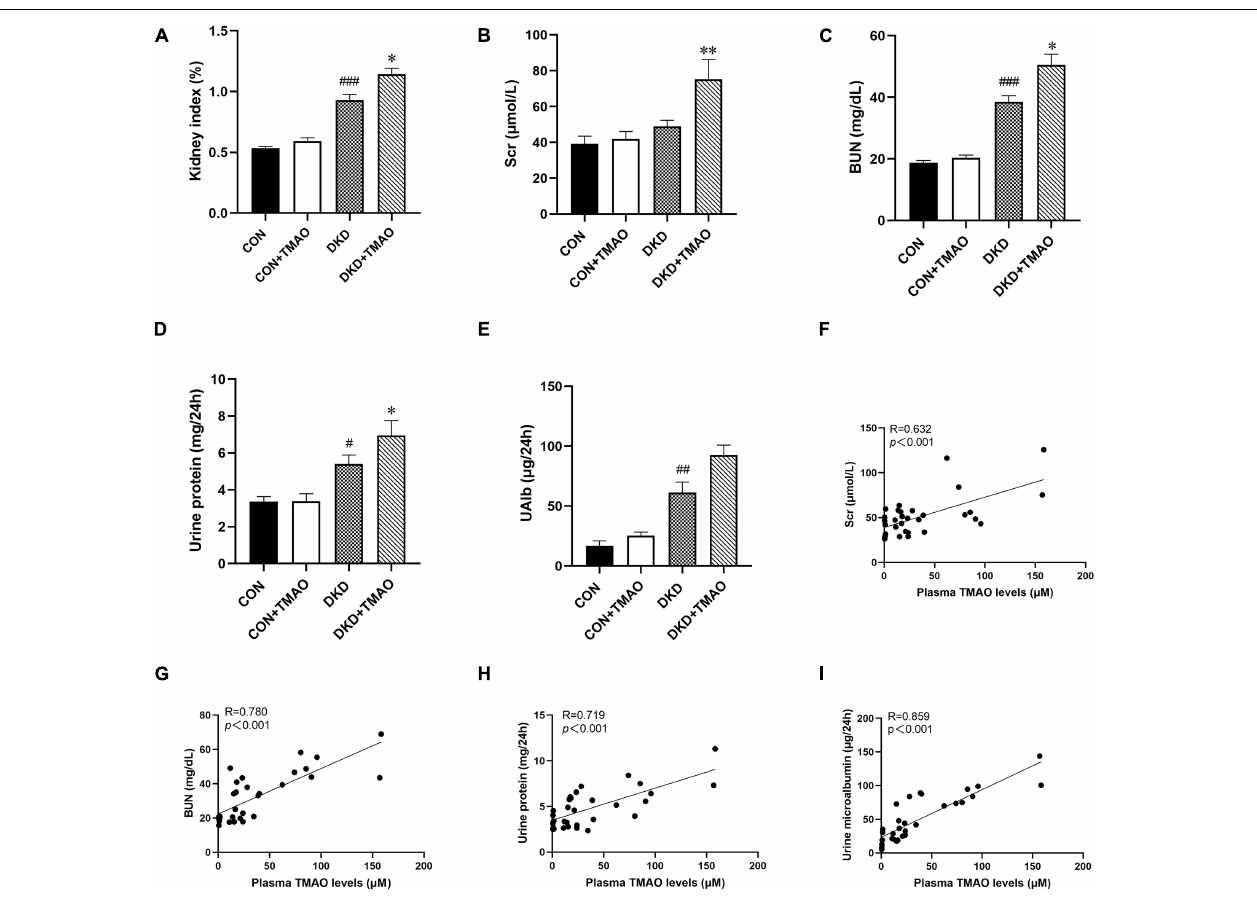
FIGURE 3 | Parameters of renal function in rats. (A) Kidney index (kidney weight/body weight), (B) Scr, (C) BUN, (D) Urine protein, (E) Urine microalbumin. Plasma TMAO levels were significantly correlated with renal function parameters Scr (F) , BUN (G) , Urine protein (H) , and Urine microalbumin (I) . Data are presented as mean ± SEM ( n = 8 for each group). # P < 0.05, ## P < 0.01, ### P < 0.001 vs. CON, ∗ P < 0.05, ∗∗ P < 0.01 vs.